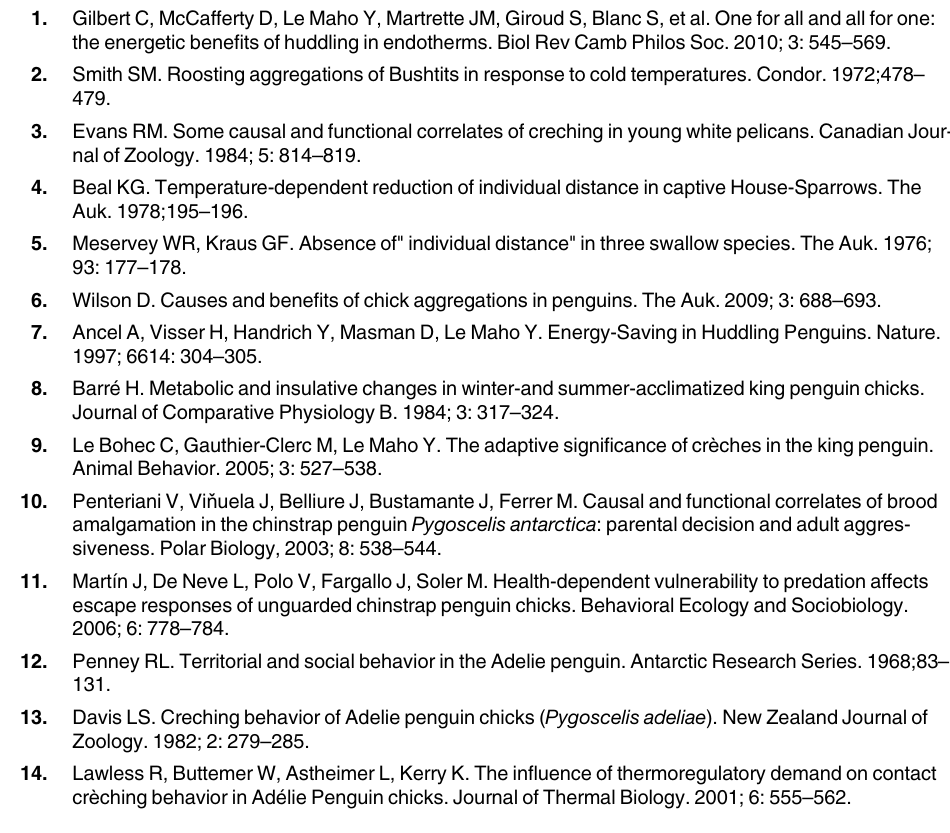
S1 Table. Complete data set of gentoo ( Pygoscelis papua) chick aggregations and environ- mental variables at four sites. S1 Fig. Images from the first day of the post-guard period in gentoo penguins ( Pygoscelis papua ) during the 2012 – 2013 breeding season at each of our four study sites: A) Maiviken, B) Georges Point, C) Port Lockroy, and D) Petermann